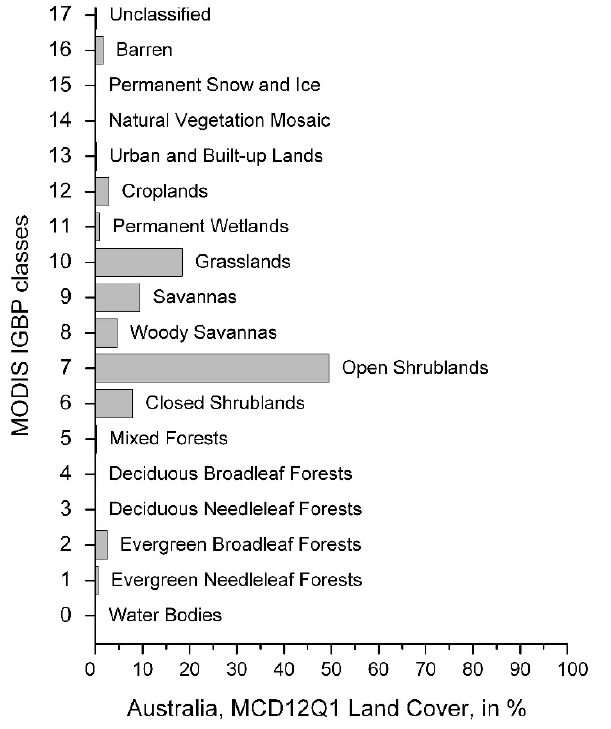
Figure 3. The contributions of different IGBP classes to Australia’s land cover (MCD12Q1, 2018) are presented.